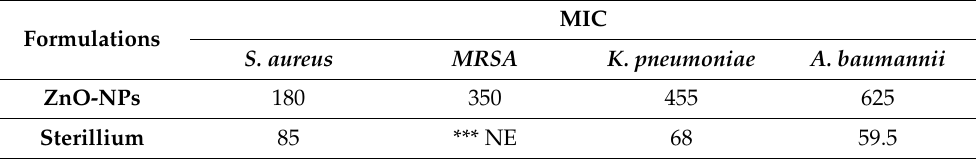
Table 4. * MIC values of ZnO-NPs (µg/mL) and Sterillium ( v/v %) recorded for S. aureus, MRSA, K. pneumoniae , and A. baumannii, and their ** CC50 toward human dermal fibroblast cells (HDFa). Formulations